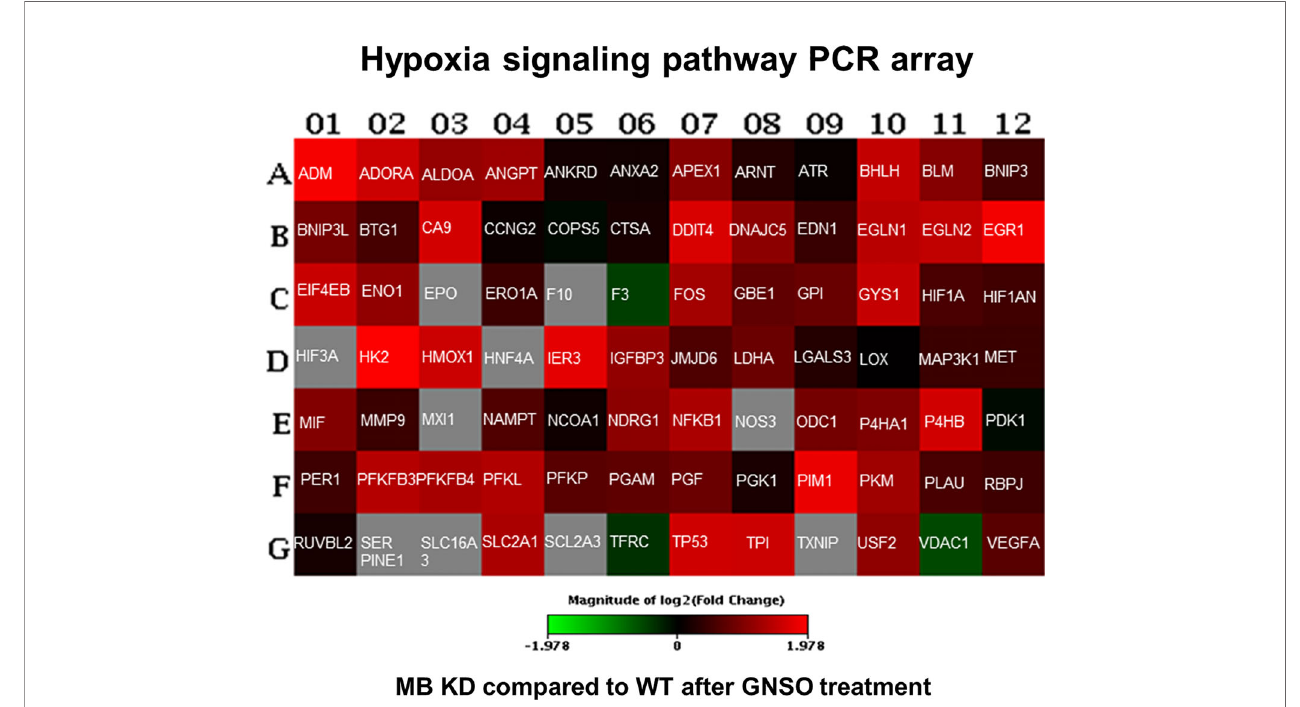
FIGURE 5 | Human hypoxia signaling pathway analysis. WT and KD MDA-MB-468 cells were treated with 500 μM GNSO for 3 h to stimulate HIF-1 a accumulation. Changes in expression of 84 genes related to hypoxic signaling were analyzed between KD and WT cells using the RT² Pro fi ler ™ PCR Array Human Hypoxia Signaling Pathway (Qiagen). After MB knockdown, most of the genes involved in hypoxic signaling showed an increased expression compared to WT cells. Changes are represented in a heat-map format giving the log 2 fold changes with green = underexpression in KD cells compared to WT cells, red = overexpression in KD cells compared to WT cells and grey = not analyzable. The exact fold change values are depicted in Supplementary Table 1